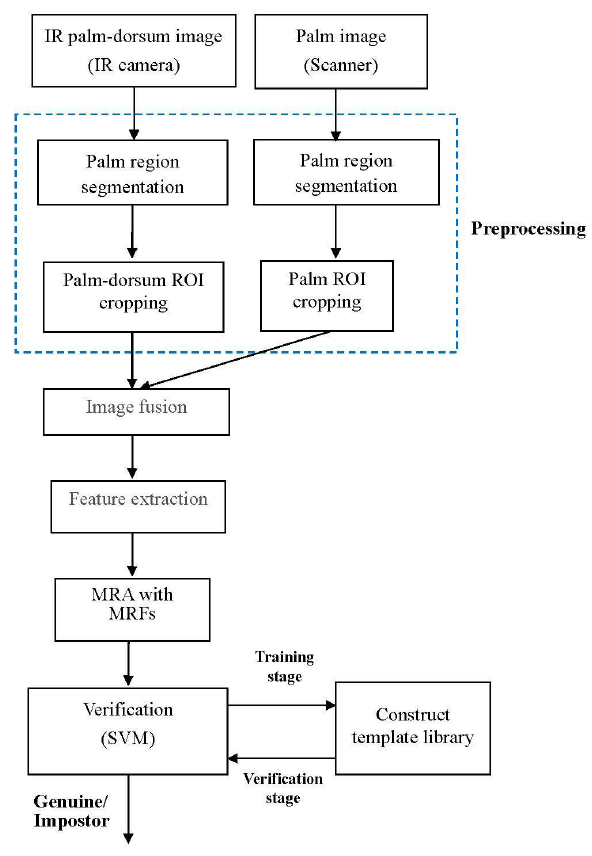
Figure 1. Block diagram of the proposed method.